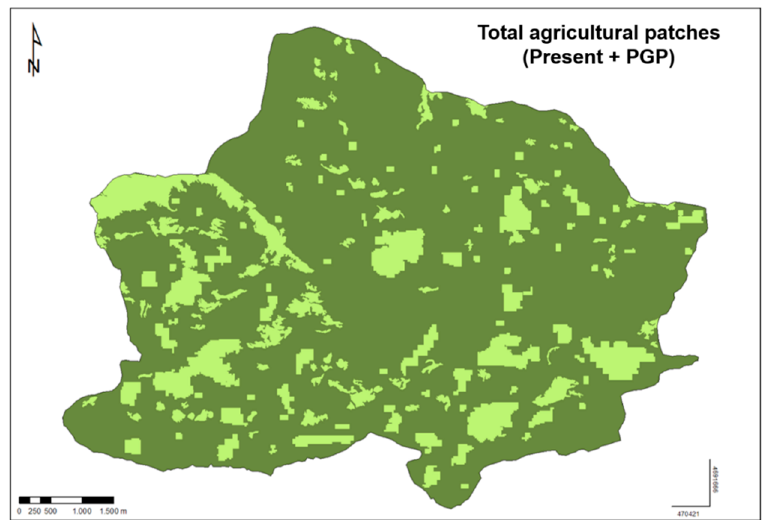
Figure 7. Agricultural patches generated using PGP algorithm.